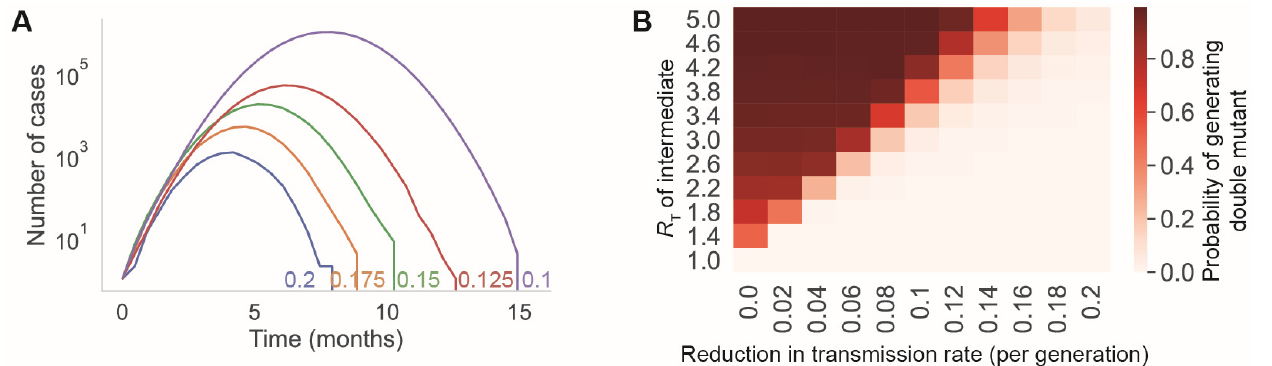
Figure 3. Limiting the transmission of a new SARS-CoV-2 single mutant reduces the risk of generating more-transmissible variants. ( A ) Example infection prevalence trajectories with different transmission reduction rates (colors; parameter values labeled on the plot). ( B ) Probabilities of generating a double-mutant lineage before the extinction of the single mutant, for different values of the single-mutant transmissibility ( y -axis) and the transmission reduction rate ( x -axis). Each parameter set had n = 10,000 simulation runs.